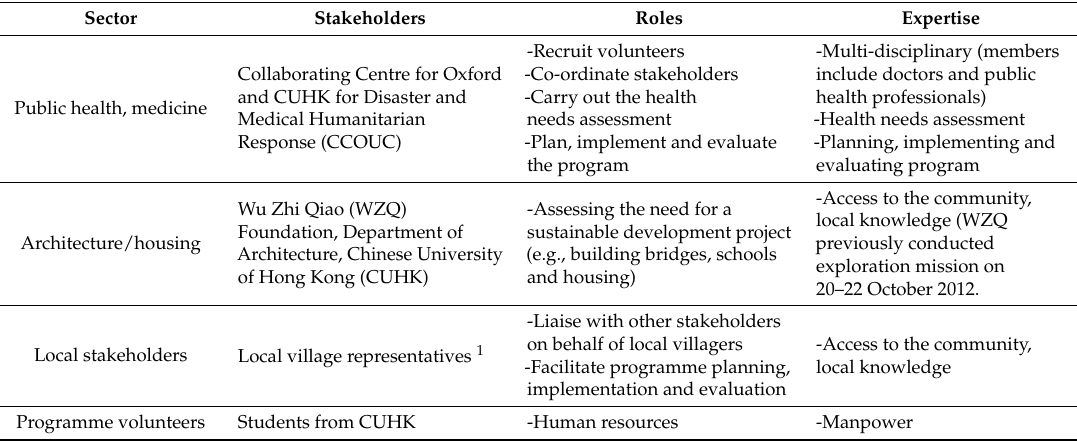
Table 2. Stakeholders and their